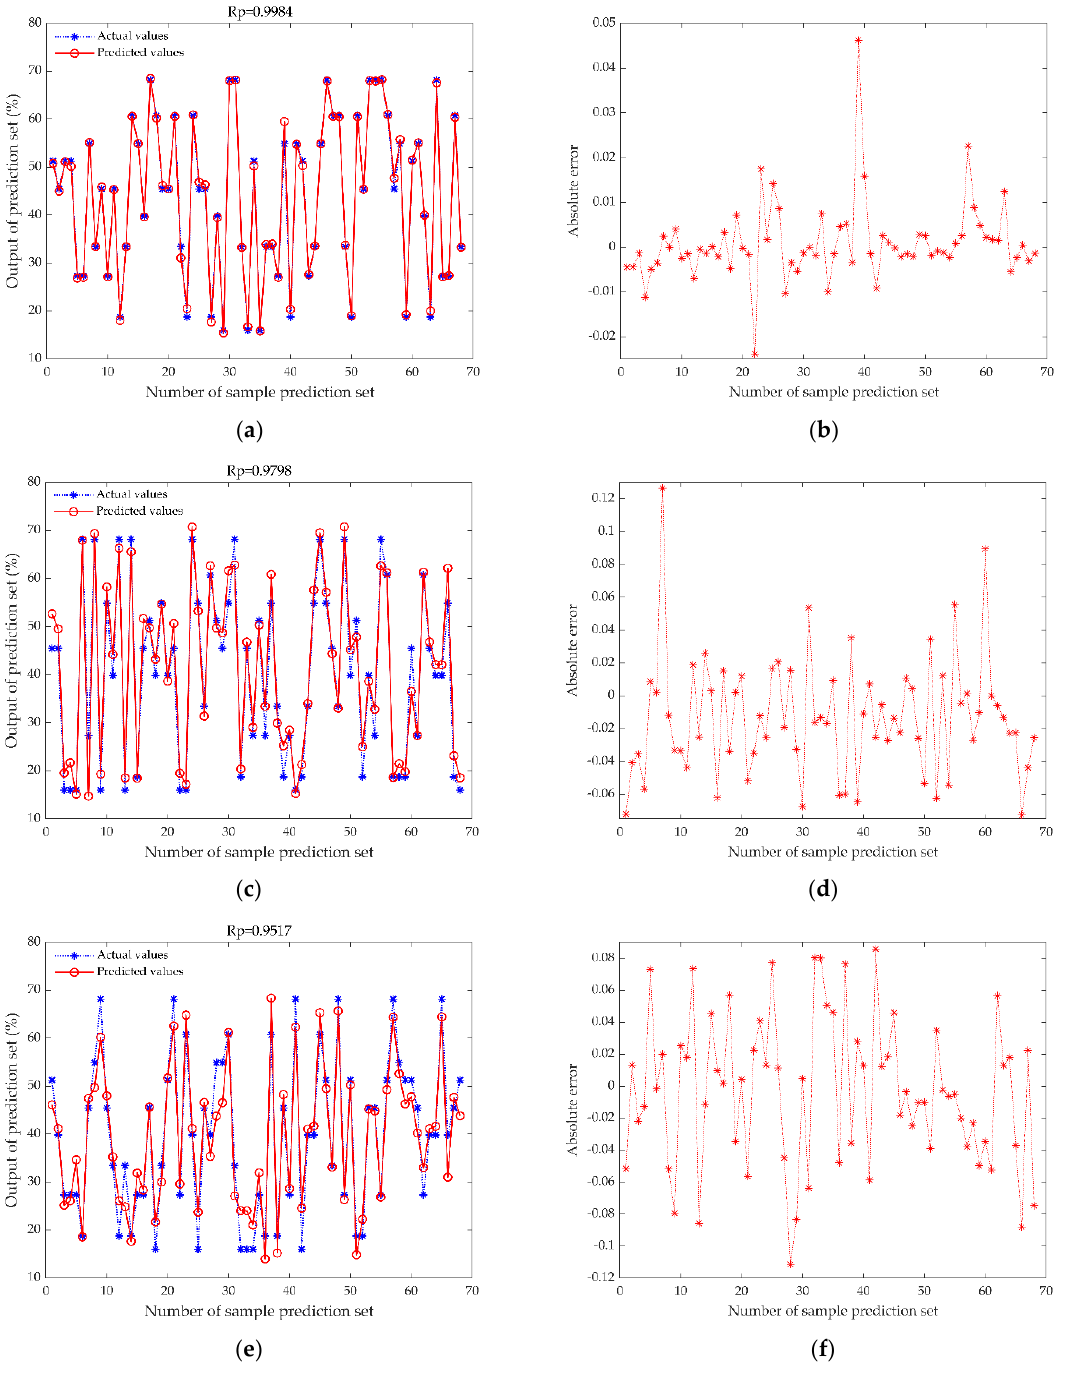
Figure 9. Results of the DF-WOA-ENN model and the competitor models. ( a ) MDF-WOA-ENN model’s scatter plot, ( b ) MDF-WOA-ENN model’s absolute error plot, ( c ) MDF-SVR model’s scatter plot, ( d ) MDF-SVR model’s absolute error plot, ( e ) MDF-PLSR model’s scatter plot, ( f ) MDF-PLSR model’s absolute error plot. The actual values are the moisture content measured by the rapid moisture analyzer, the predicted values are the moisture content predicted by different models, and the absolute errors are equal to the predicted value minus the actual value.